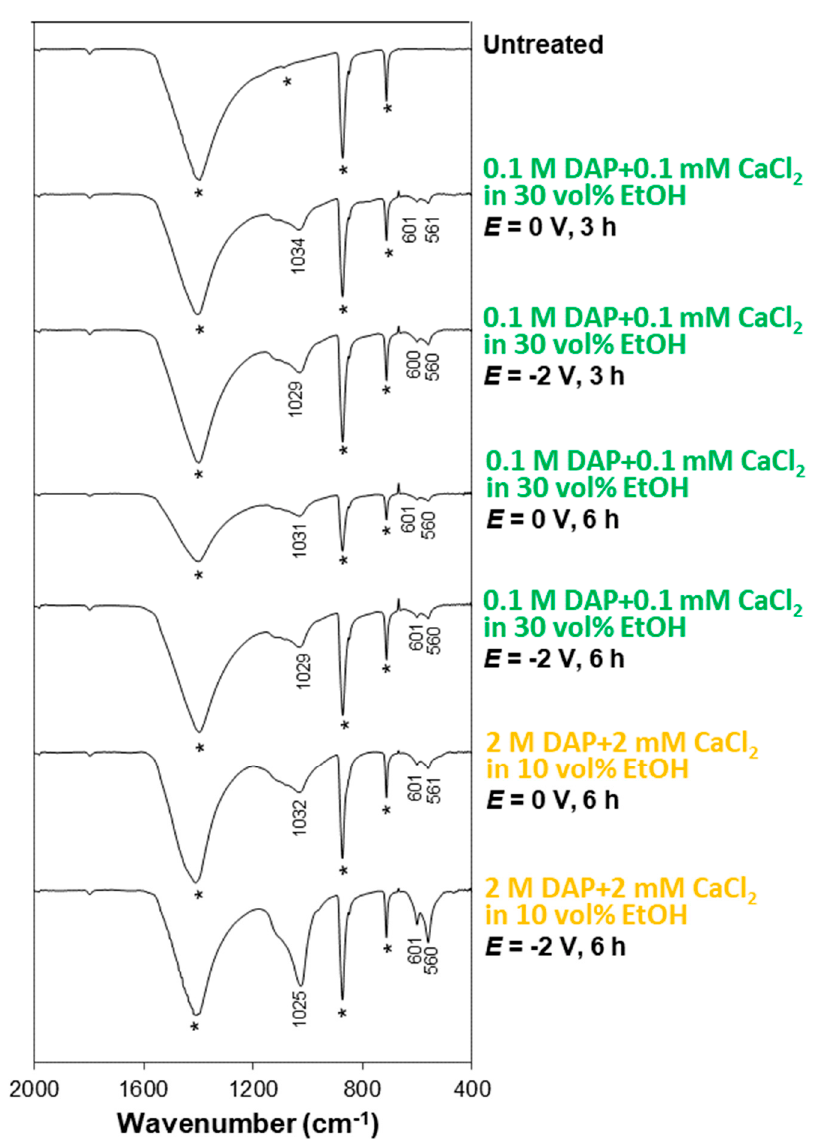
Figure 12. FT-IR spectra of untreated and treated samples (tested with coated edges), after the acid test (in the FT-IR spectra, bands owing to the substrate are marked by a star, while the position of the new bands owing to CaP phases is reported).